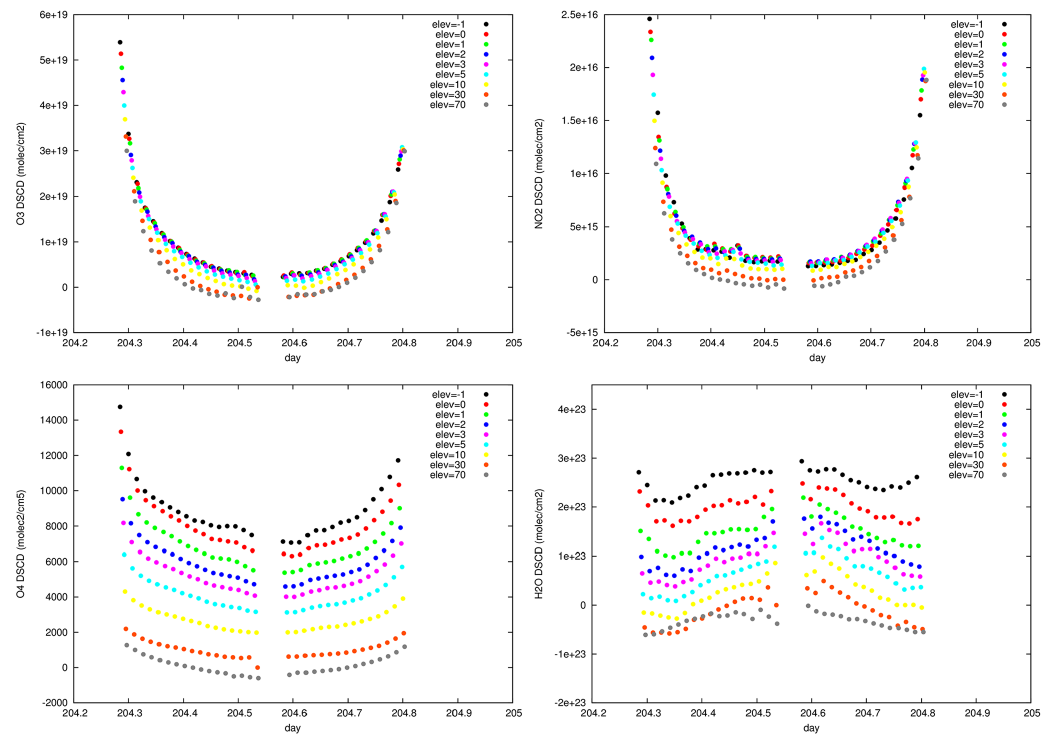
Figure 7. MAX-DOAS measured DSCD of O 3 (top left), NO 2 (top right), O 4 (bottom left) and H 2 O (bottom right) for day 204 and for all elevation angles.